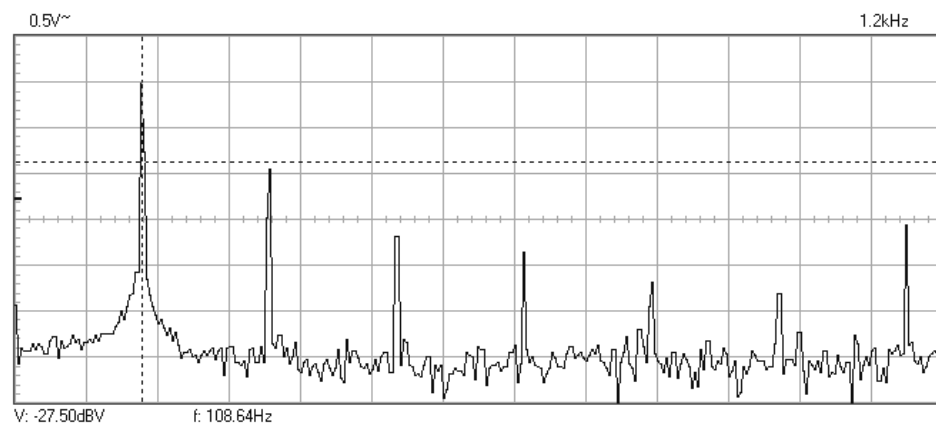
Figure 13. Amplitude spectrum recorded after 13,332 cycles at 111.1 Hz.